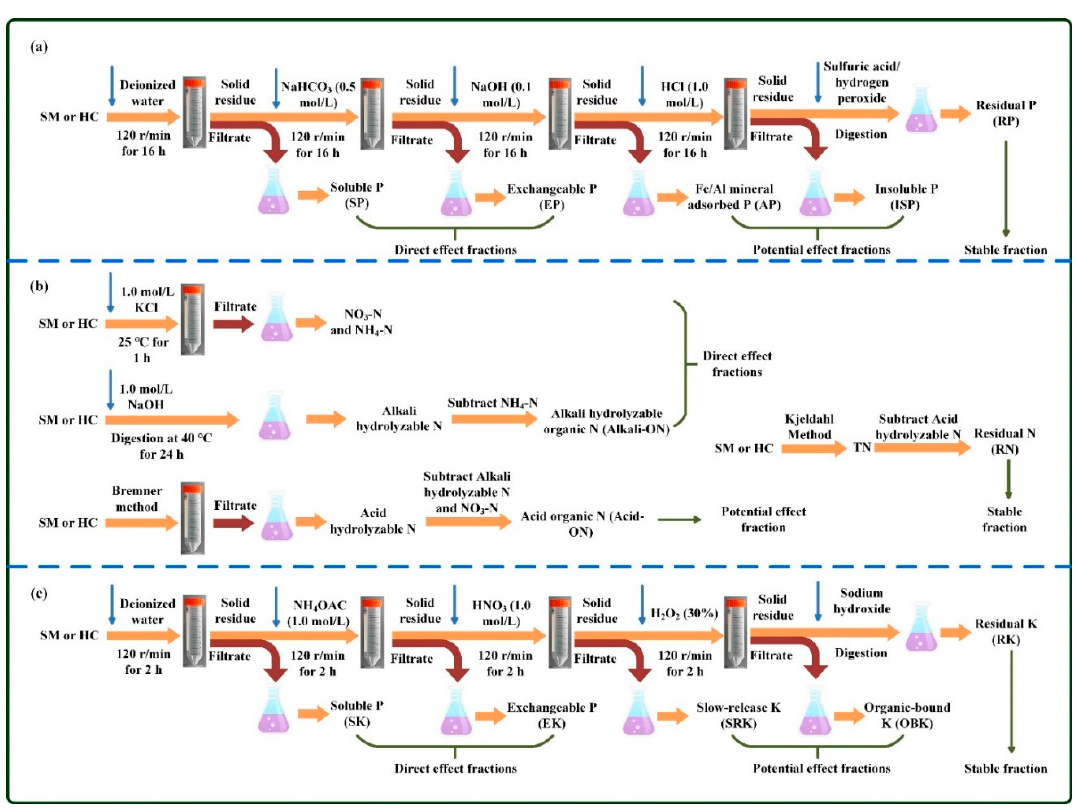
Figure 1. Extraction methods of different chemical forms of phosphorus ( a ), nitrogen ( b ) and potassium ( c ).